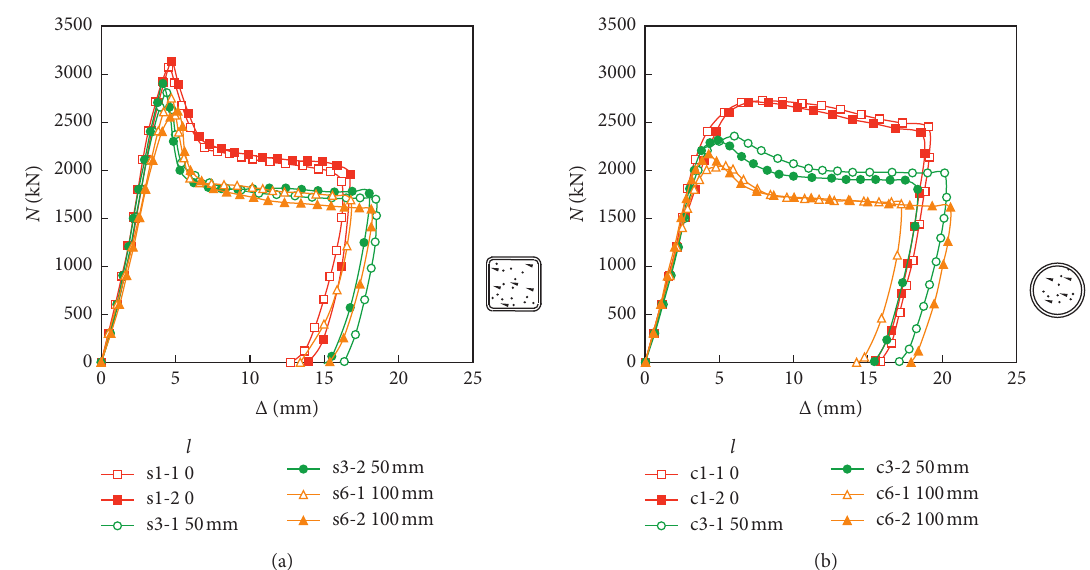
Figure 8: Effects of holes depth on load ( N ) versus deformation ( Δ ) diagrams. (a) Square section. (b) Circular section.